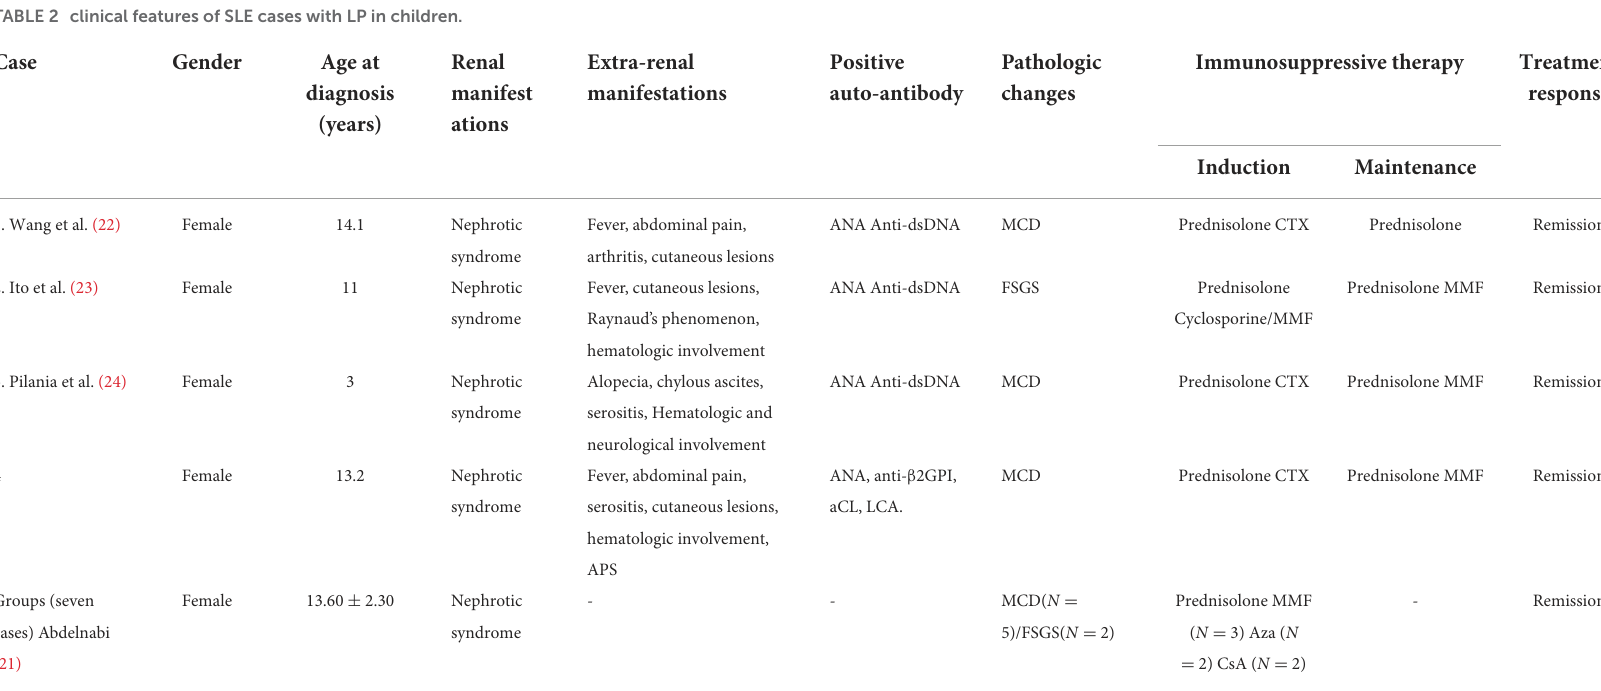
TABLE 2 clinical features of SLE cases with LP in